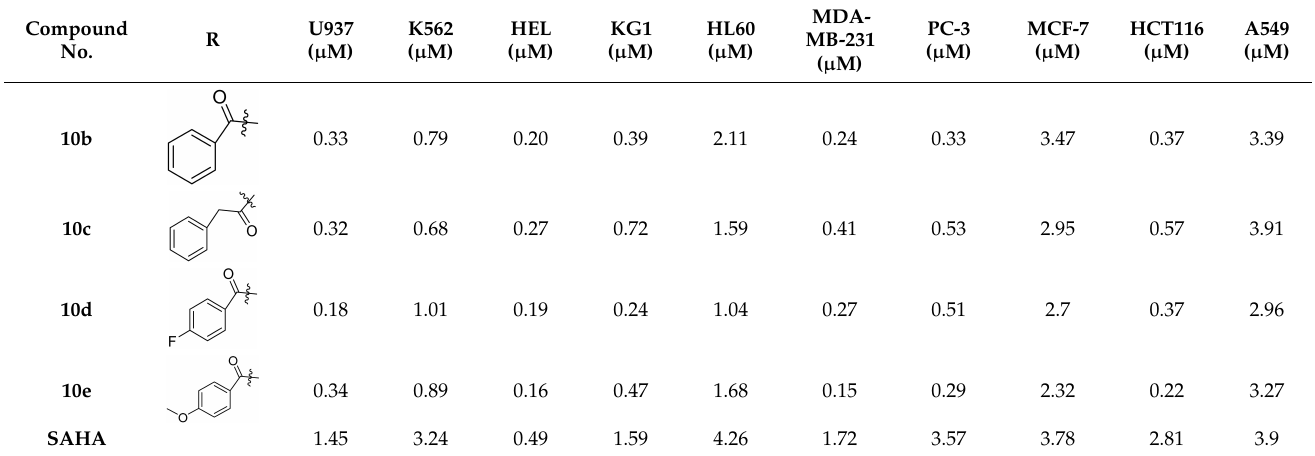
Figure 12. Structure of indole with hydroxycinnamamide hybrids and the most promising com- pound 10a. Table 10. In vitro cytotoxic activities of hybrid compounds 10 ( b – e ).